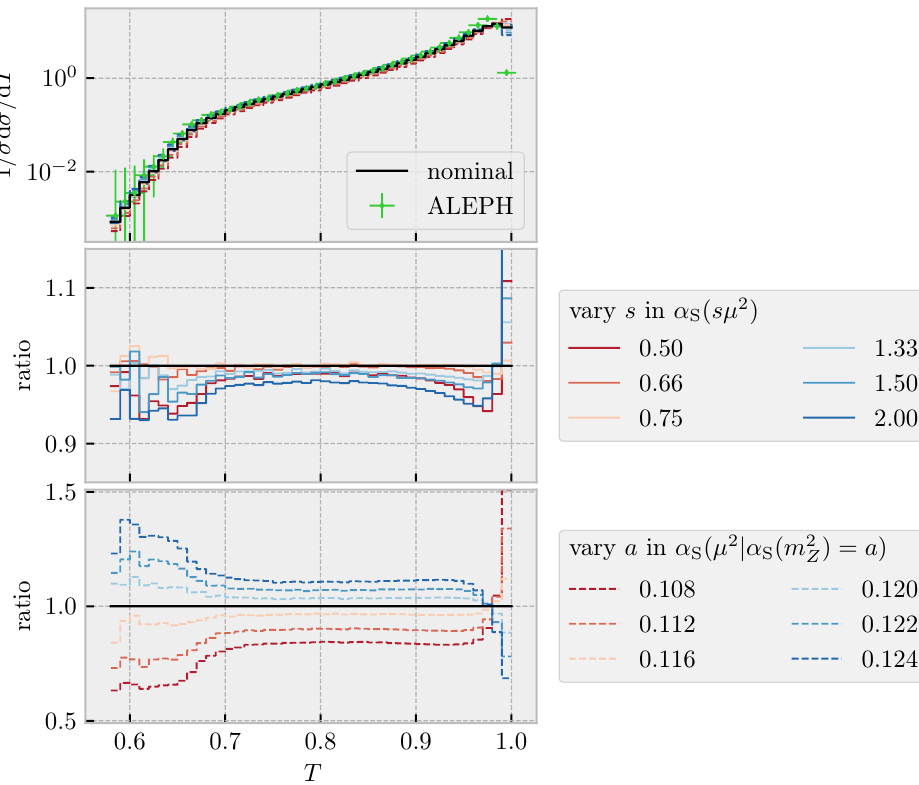
Figure 9 . The e(cid:11)ect of the sherpa Catani-Seymour shower variations on the distribution of the Thrust event shape observable. The nominal prediction ( a = 0 : 118, s = 1 : 0) is shown in black, whereas the variations are colour-coded as listed in the legend on the right. The lower panels show the scale and (cid:11) S ( m Z ) variations, respectively. Some intermediate variations that are used in the NN training and comparison are left out to prevent that the plots become too busy. In the upper panel, we also show data points from the aleph collaboration